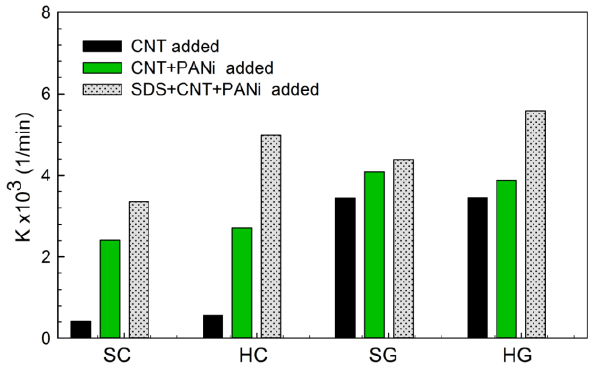
Figure 9. Contribution of composite materials to photocatalytic activity. SDS: sodium dodecyl sulfate.